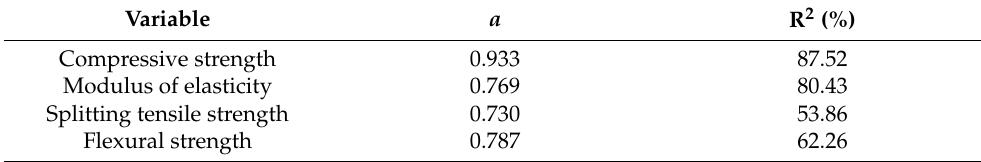
Table 5. Simple linear-regression model between standardized